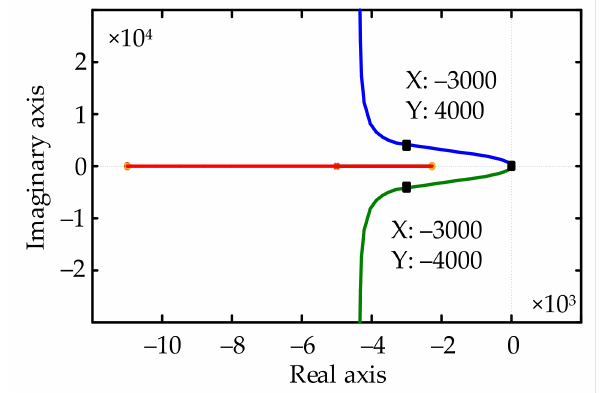
Figure 9. Root locus after